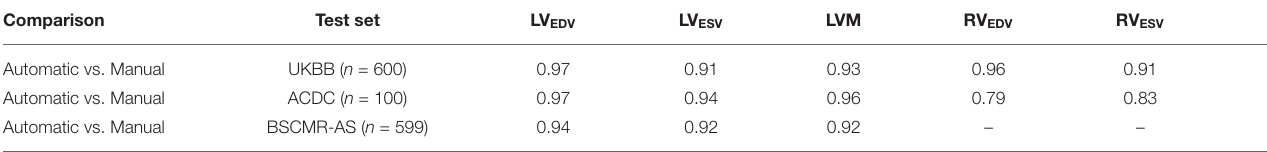
TABLE 9 | Spearman’s rank correlation coefficients of clinical parameters derived from the automatic measurements and the manual measurements on the three sets.